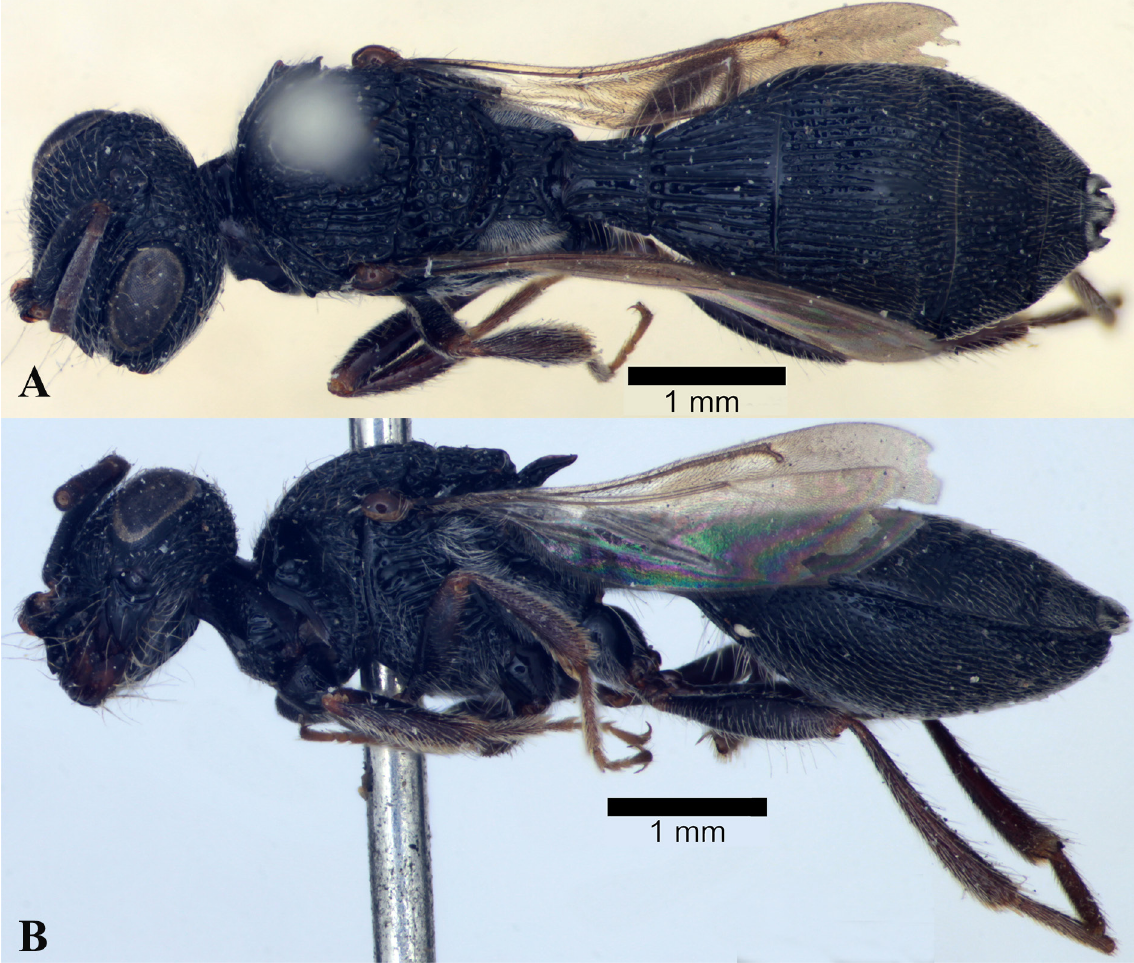
Fig. 9. Odontoscelio caelebs (Nixon, 1936). Holotype, ♀ (NHMUK 013379412). A . Habitus (dorsal view). B . Habitus (lateral view). Photos: D.G. Notton © ,